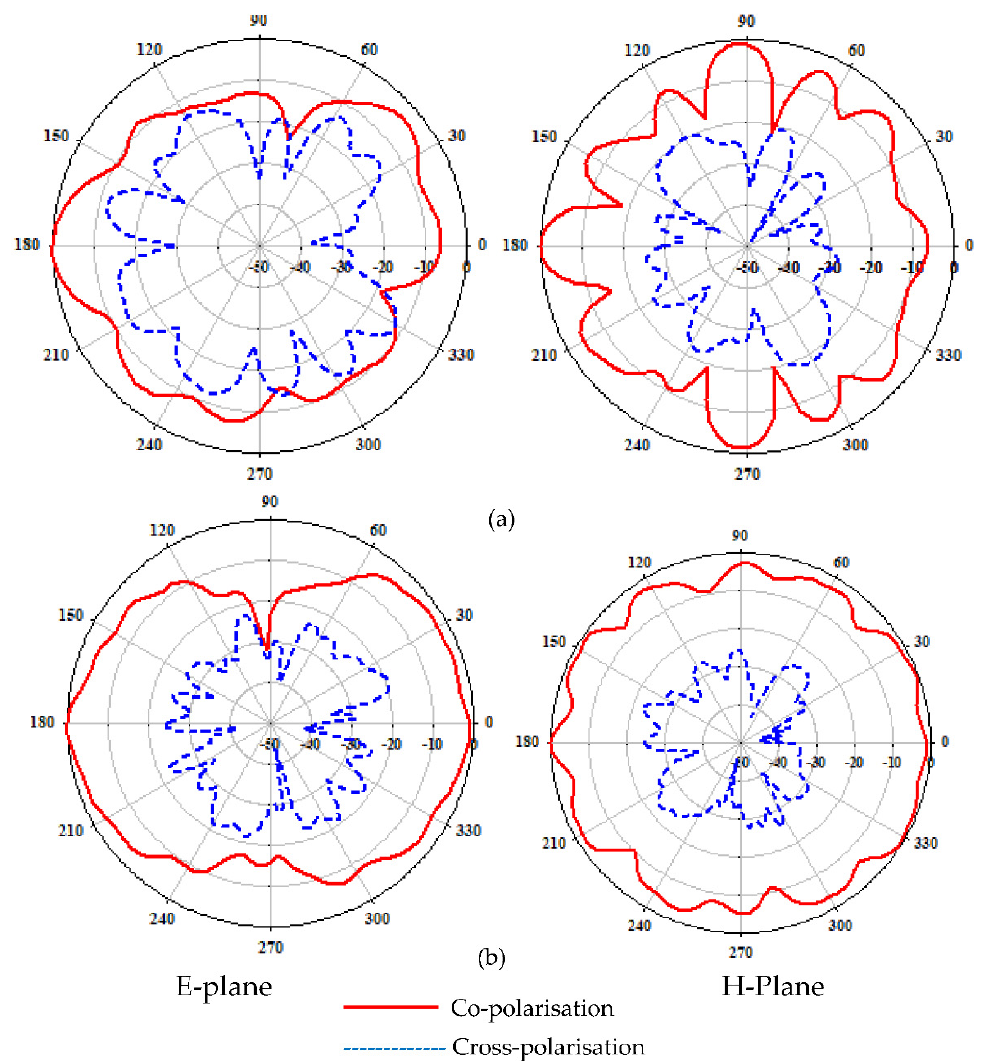
Figure 14. Radiation characteristics of the proposed ESA at ( a ) 2.4 GHz and ( b ) 5.2 GHz. Table 2. Performance comparison of the proposed antenna with the basic patch antenna. No. of No. of Frequency Size Imp. Antenna Antenna Bands (GHz) ( λ 0 ) (dBi)